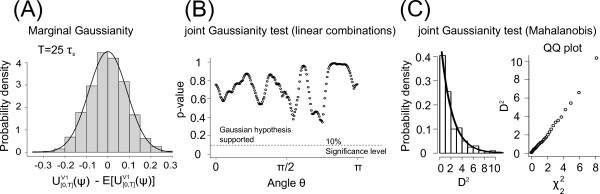
Univariate and multivariate count Gaussianity. a Univariate Gaussianity of counts U[0,T]V1(ψ)−E[U[0,T]V1(ψ)] for large bin size T=25τs. A solid black line represents the corresponding zero mean Gaussian fit. b Shapiro test p-value of the projections A=XiT⋅(cos(θ),sin(θ)), for all θ∈[0,2π). c Probability density of D2 (left). QQ-plot between the theoretically predicted χ22-quantiles and the empirical quantiles of Di2 in Eq. (35). Figures b and c are both validations of the multivariate Gaussianity of the bivariate vector X in Eq. (34). In all panelsψ=0.3, τs=1 ms, σVi=1